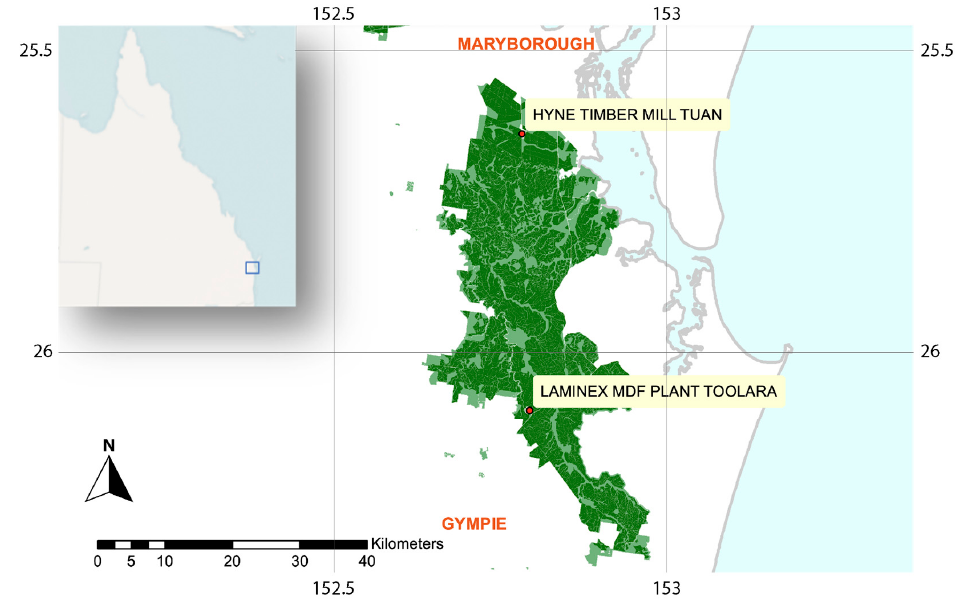
Figure 1. Map showing the location of Toolara–Tuan Forest